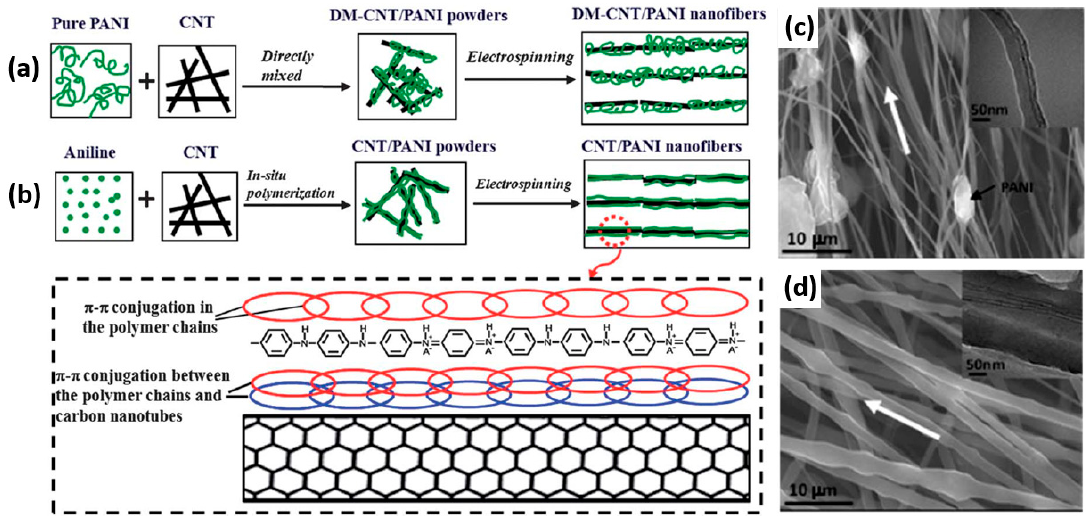
Figure 10. Schematic representations of the formation mechanism of DM-CNT/PANI ( a ) and CNT/PANI ( b ) nanofibers. The enlarged part shows the highly ordered arrangement of the PANI backbone chains on the surface of the CNTs. SEM images of the fiber mats of DM-CNT/PANI (40 wt%) ( c ) and CNT/PANI (40 wt%) ( d ). The inserts are the TEM images of a single fiber. Arrows denote the alignment direction of fibers. Readapted with permission from The Royal Society of Chemistry [87].